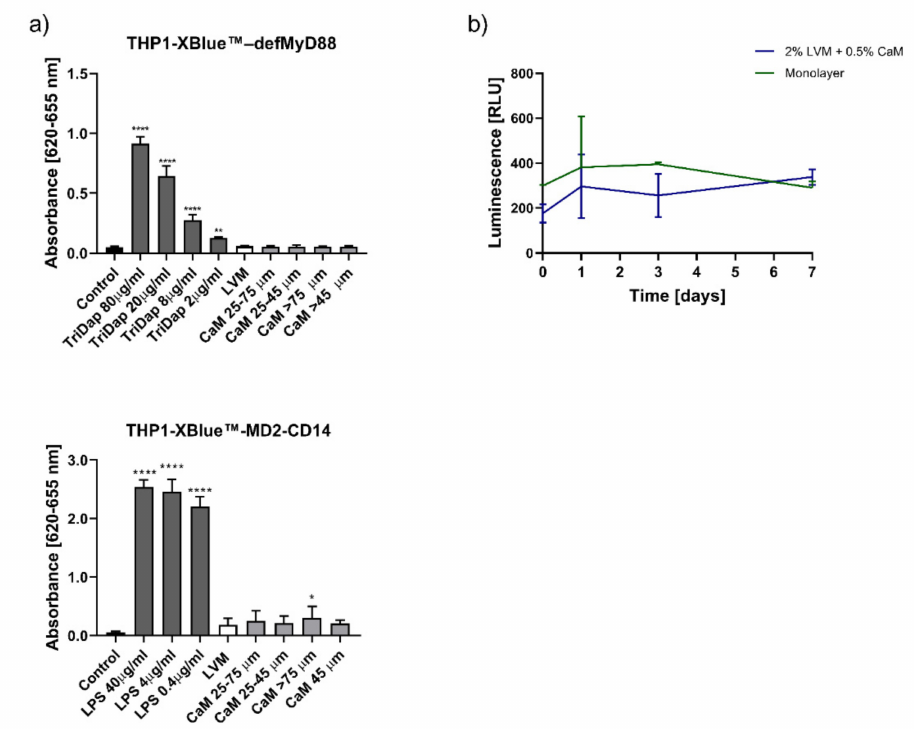
Figure 3. Optimization of the injectability of the hydrogels. ( a ) Influence of the percentage of the alginate and cross-linker on the MRI signal stability, ( b ) influence of the addition of the MnCl2 on the GRPs viability. (* p < 0.05, ** p < 0.01, **** p <